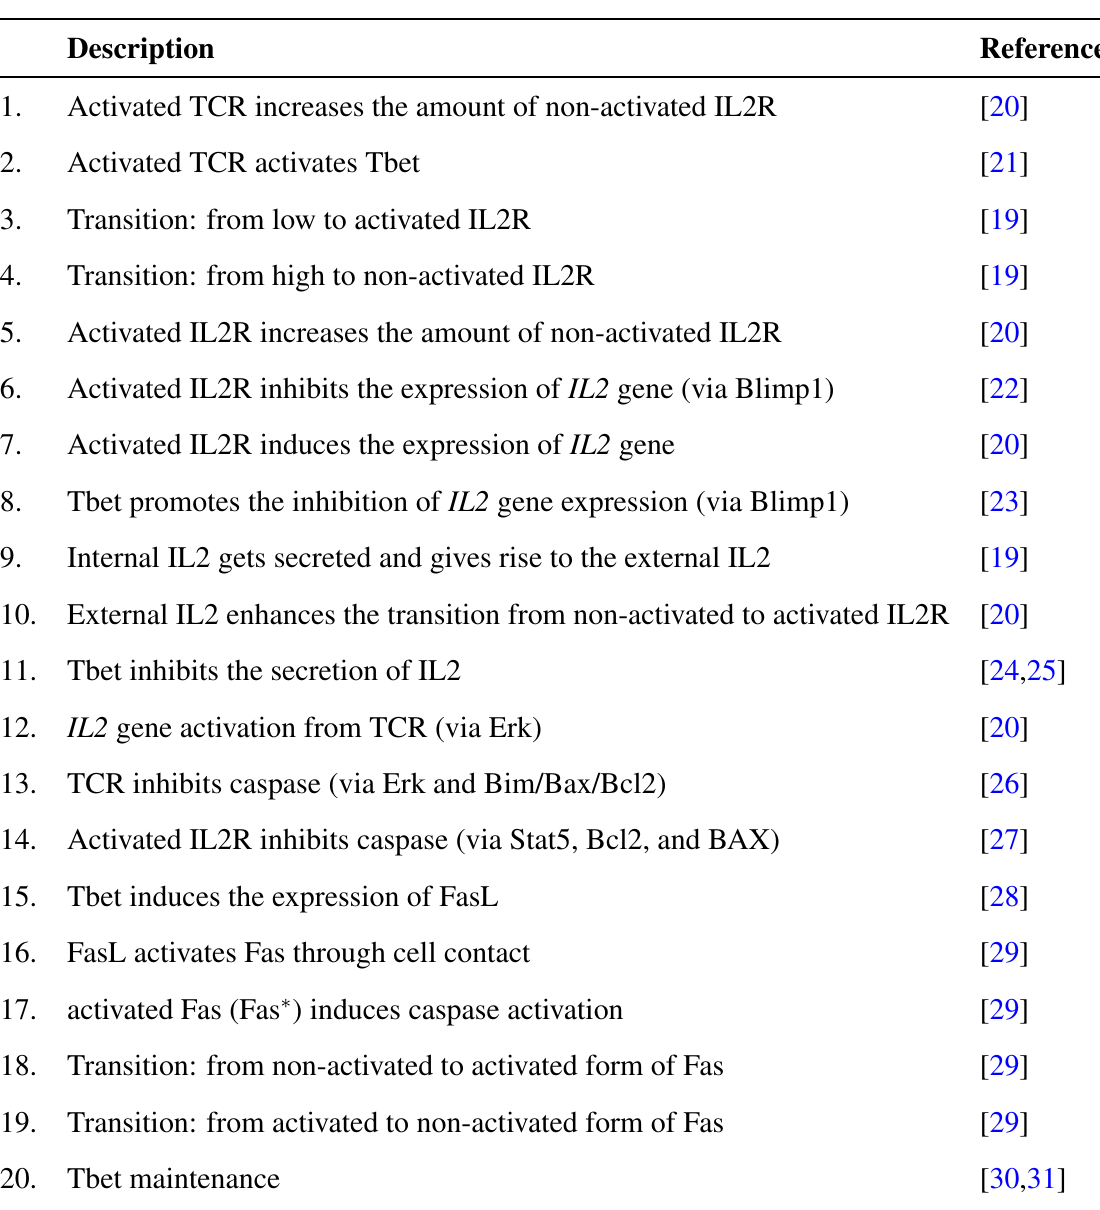
Table 1. Description of the molecular signaling pathways in Figure